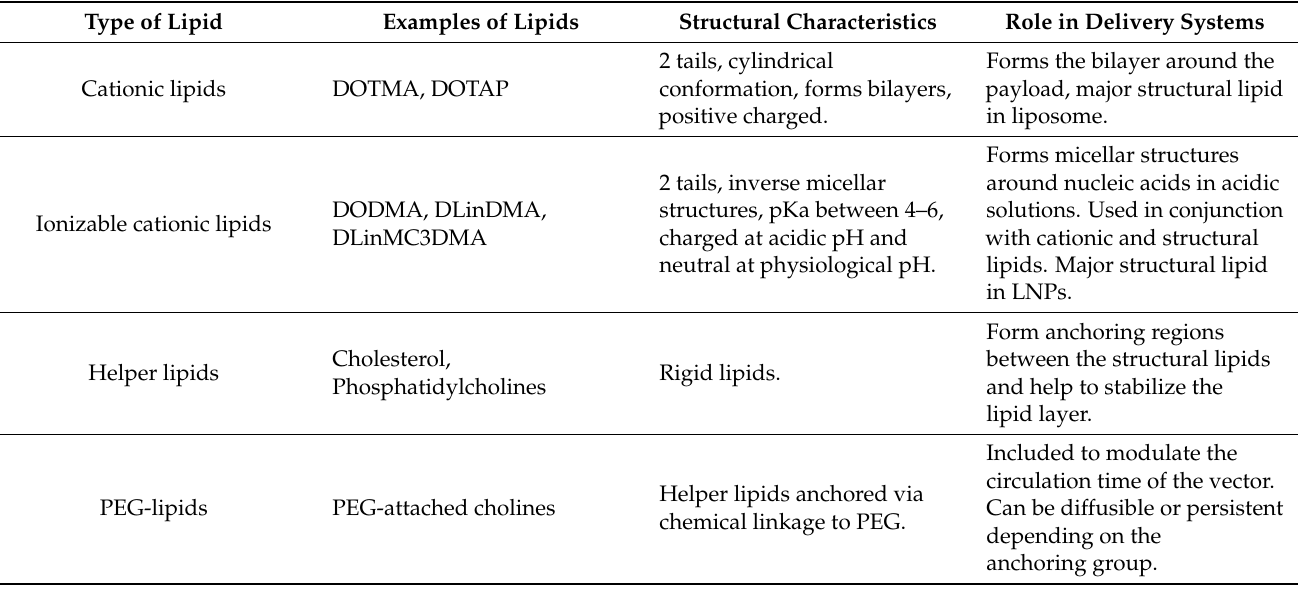
Table 4. Types of lipids used in lipid-based nucleic-acid-delivery